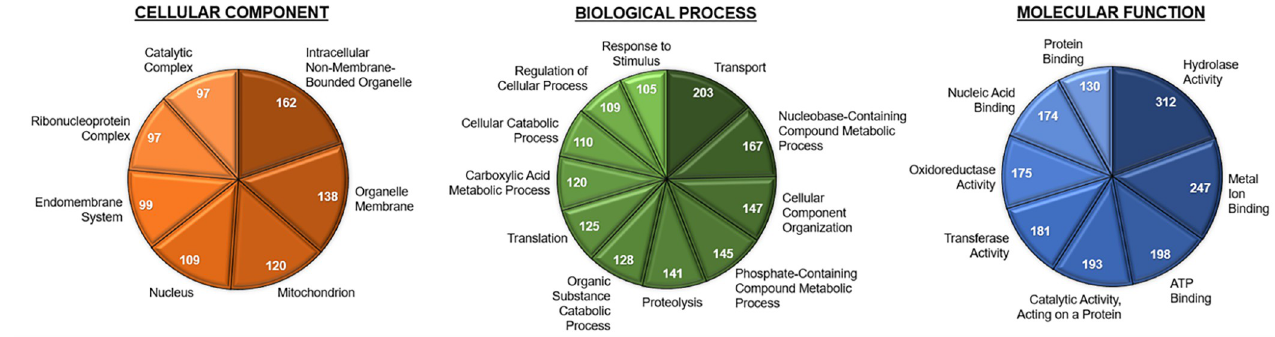
Fig 2. Protein distribution among unique IDs by gene ontology analysis. A) Cellular component. B) Biological process. C) Molecular function.